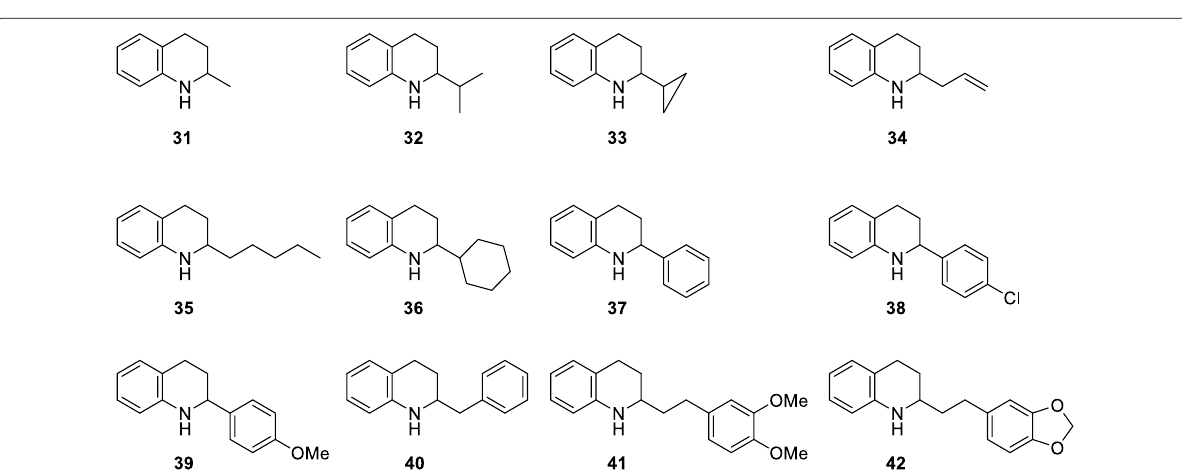
Fig. 10 2-Substituted THQs were tested as substrates in deracemization using CHAO